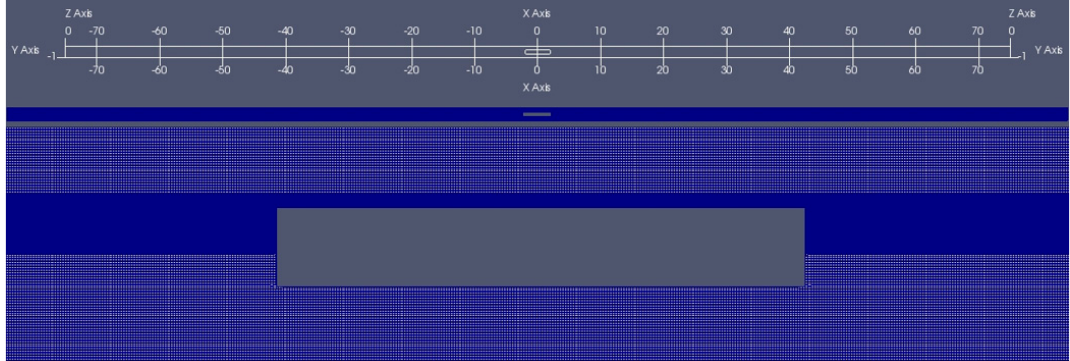
Figure 3. General mesh assembly for the study of solitary wave scattering by a pontoon—Open- FOAM mode.